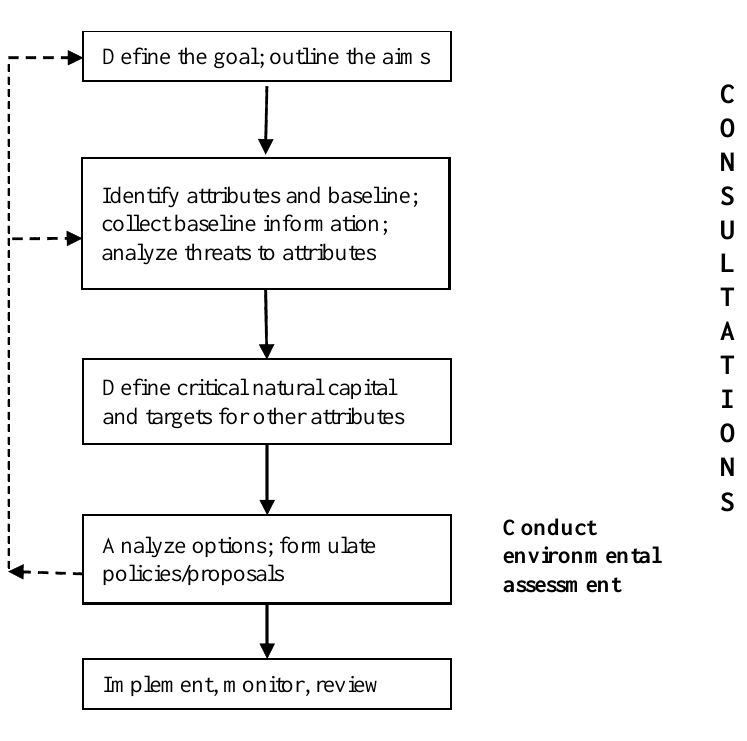
Fig. 3: The basic Environmental Planning Process (DTA/CAG,